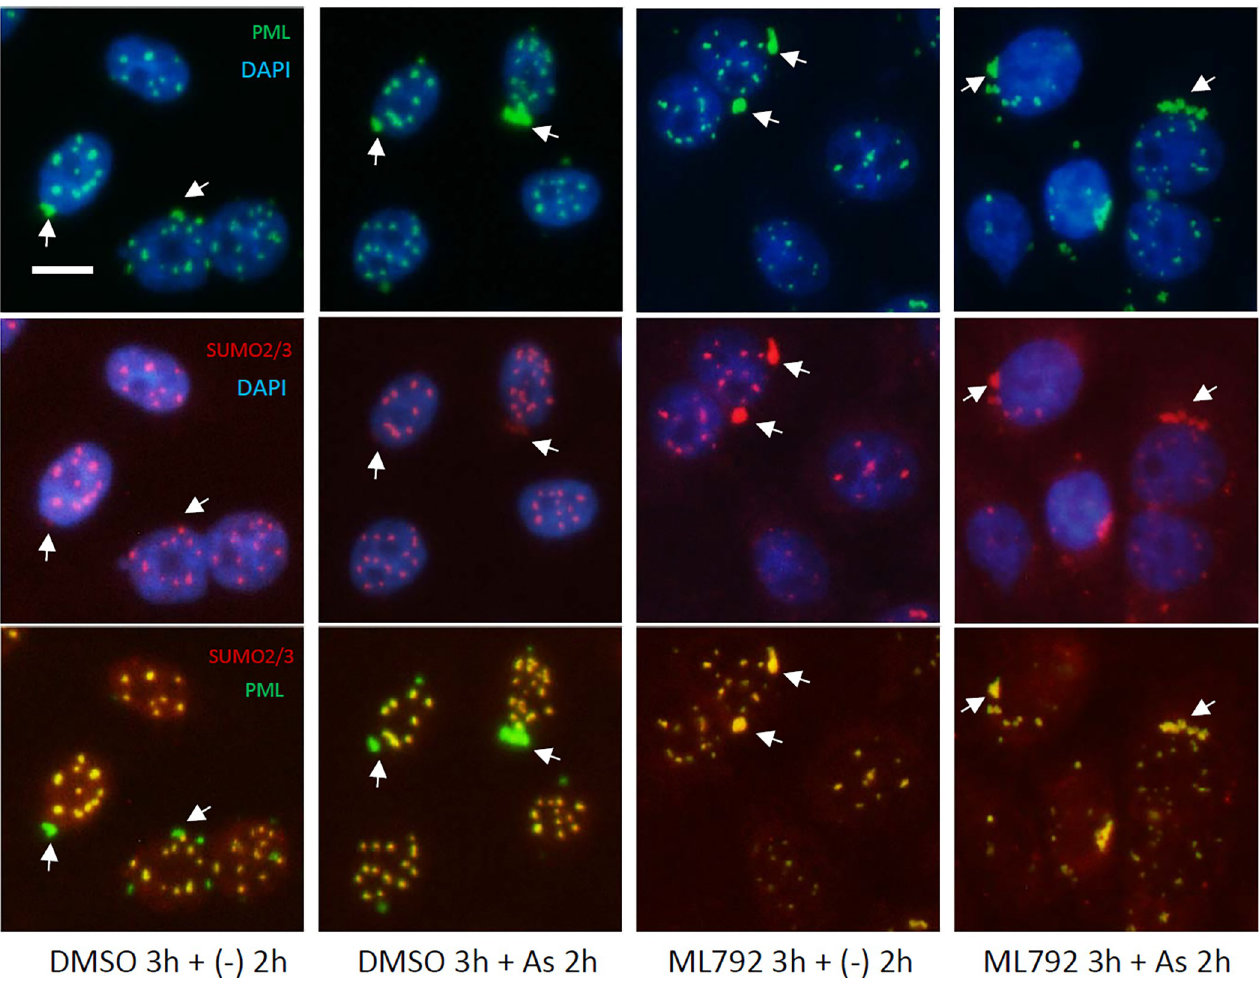
Fig 10. Fluorescent immunostaining of ML792–pretrreated CHOGFPPML cells to detect PML and SUMO2/3. The cells were treated with 0.1% DMSO or 20 μ M ML792 for 3 h, then further treated with 3 μ M As 3+ or left untreated for 2 h. Note that SUMO2/3 in peri–nuclear PML aggregates (arrow) was decreased in the DMSO–treated cells, whereas a substantial amount of SUMO2/3 retained with GFPPML in the ML792–treated cells. Scale bar = 10 μ